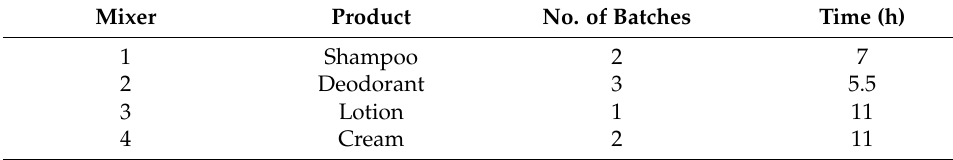
Table A10. Production data for case study 4 [11].